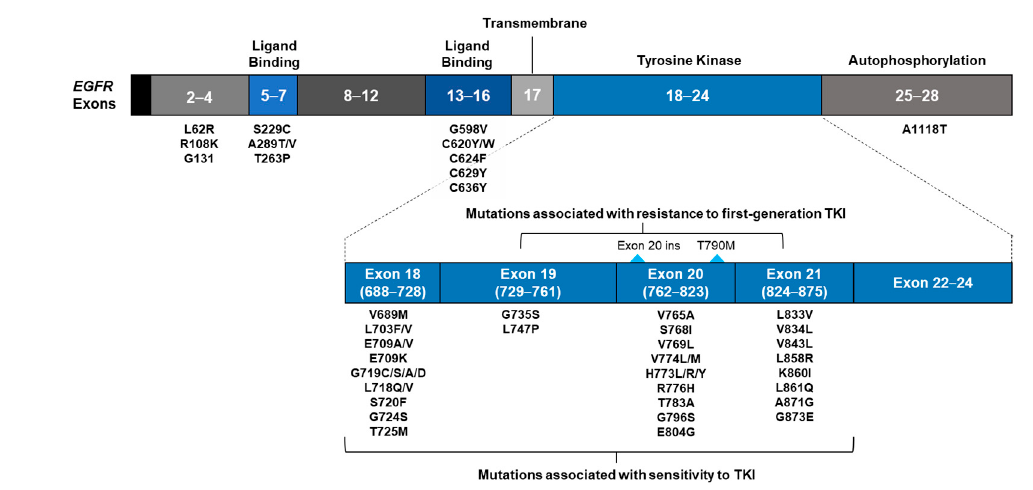
Figure 3. Classification of samples with EGFR driver mutations with a breakdown of L858R mutations ( left ) and exon 19 deletions ( right ). Abbreviations: amp, amplification; del, deletion.